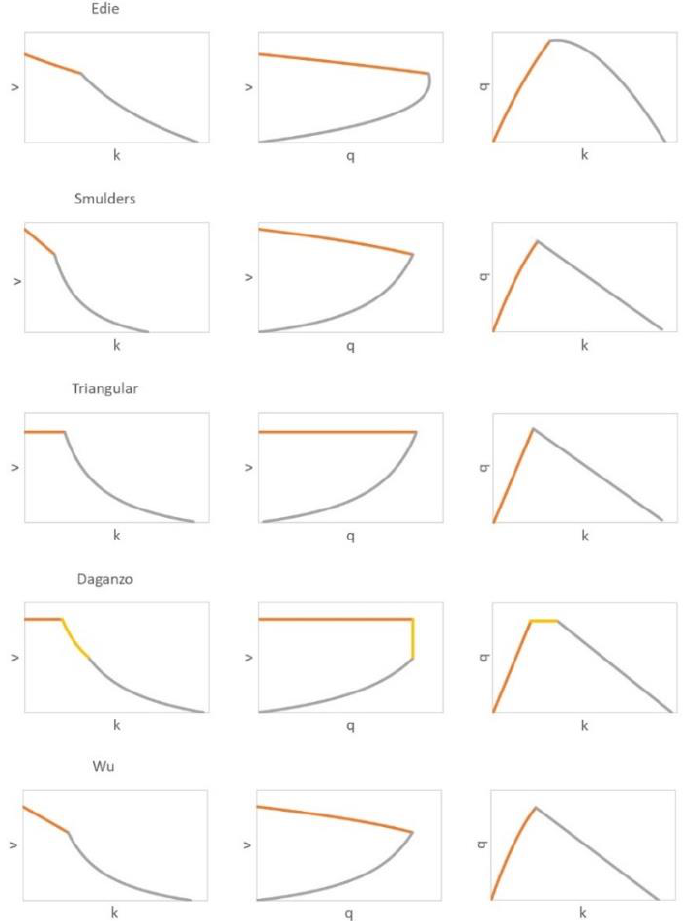
Figure 2. Relationships v(k), v(q), and q(k) in selected multi-regime models (assuming model con- tinuity).